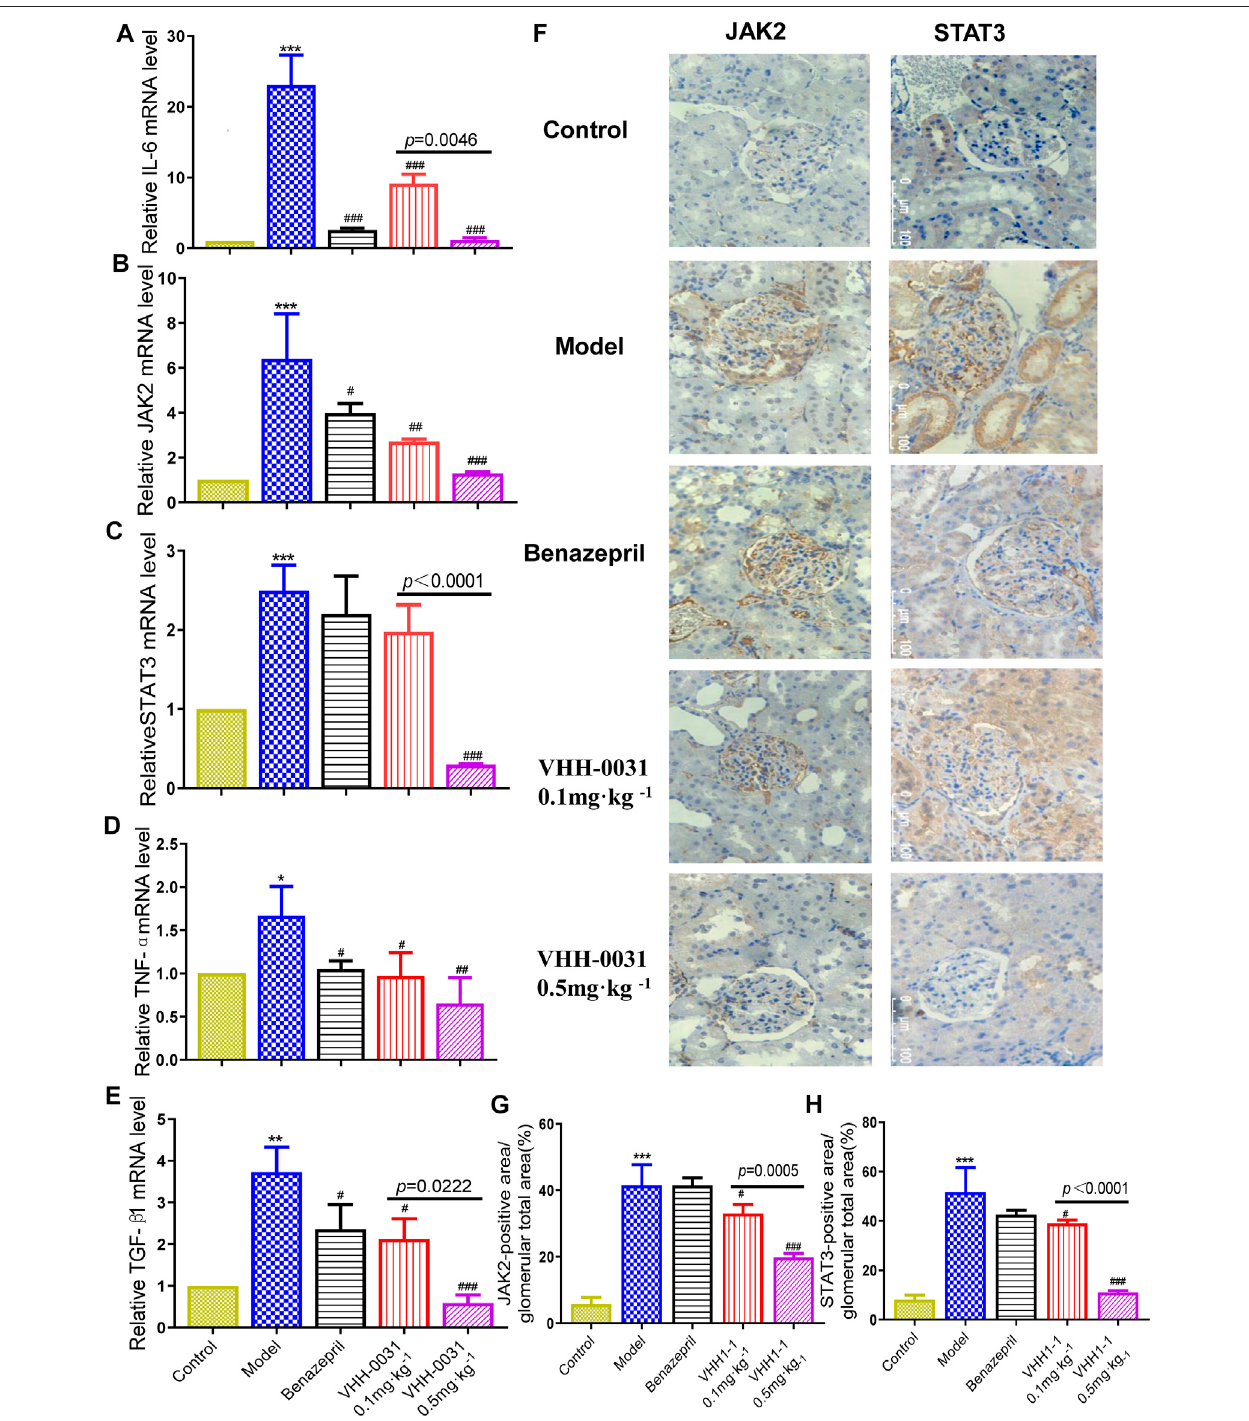
FIGURE4| Effect ofVHH-0031onJAK2-STAT3signalingpathway inSTZ-inducedratskidney.ThemRNAexpressionofIL-6 (A) ,JAK2 (B) ,STAT3 (C) ,TNF- α (D) and TGF- β 1 (E) inkidneydetermined byqRT-PCR (F) Theexpression ofJAK2and STAT3stainingmeasured byimmunohistochemistryinkidney,Bar (cid:1) 100 μ m( × 400). Quanti fi cation of JAK2 (G) and STAT3 (H) protein measured by immunohistochemical staining. Data represents the mean ± SD for six rats per group. Control: SD rats withoutSTZtreatment,Model: SD ratswithSTZtreatment,Benazepril 10 mg kg − 1 :SDratswithSTZtreatment inpresence ofbenazepril(10 mg kg − 1 ),VHH-0031 0.1 and 0.5 mg kg − 1 : SD rats with STZ treatment in presence of the recombinant anti-IL-6R fusion proteins (0.1 and 0.5 mg kg − 1 ). ** p < 0.01, *** p < 0.001 vs control group, # p < 0.05, ## p < 0.01, ### p < 0.001 vs model group.